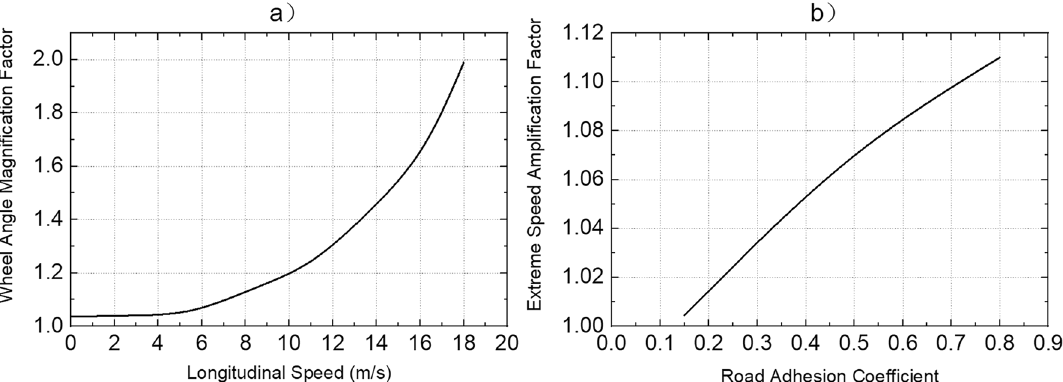
Figure 2. ( a ) Relationship between average wheel angle magnification factor K δ and longitudinal speed; ( b ) Relationship between extreme speed magnification factor K v and road adhesion